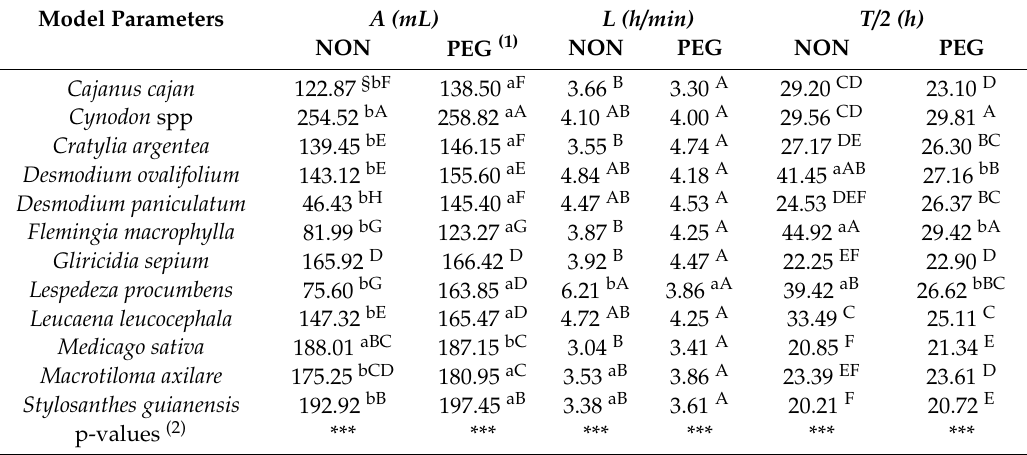
Table 3. Kinetic parameters of gas production modeled according to France et al. (1993) [10] of legumes forages incubated with a rumen fluid